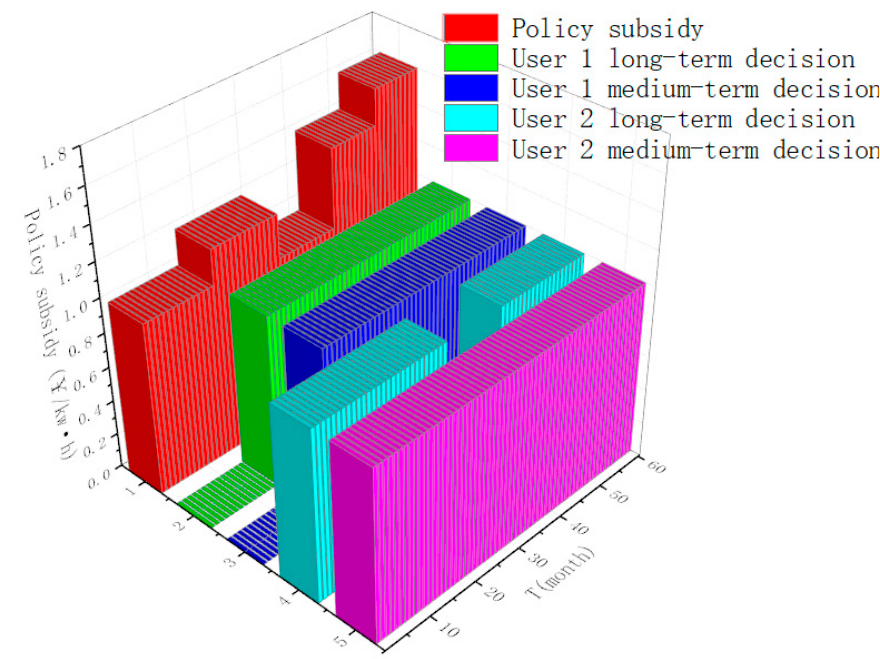
Figure 15. Medium- and long-term decision-making of flexible load users.